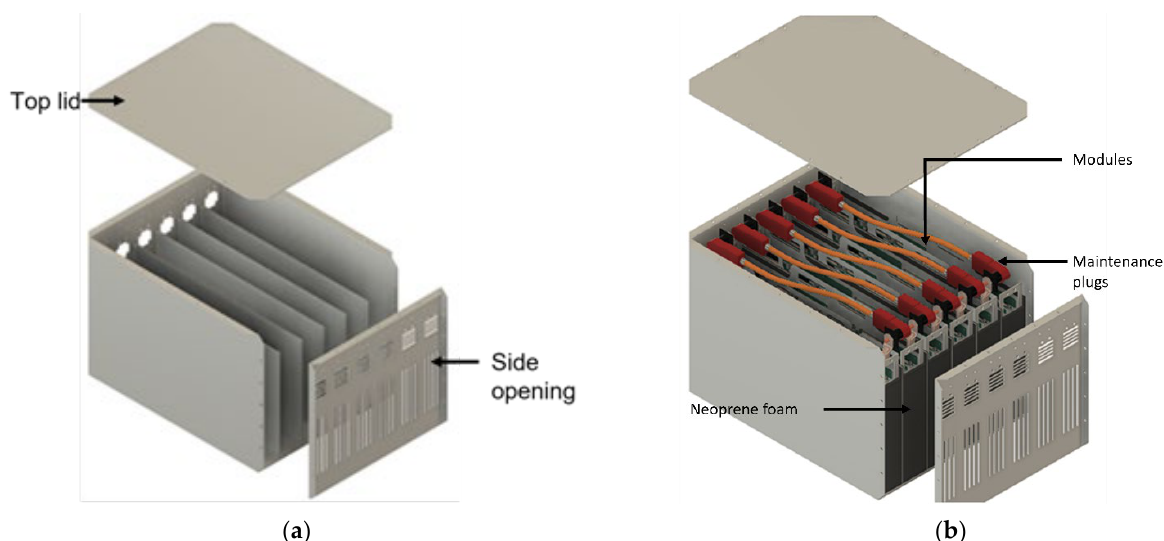
Figure 11. ( a ) Accumulator container without the modules. ( b ) Assembled accumulator container with the